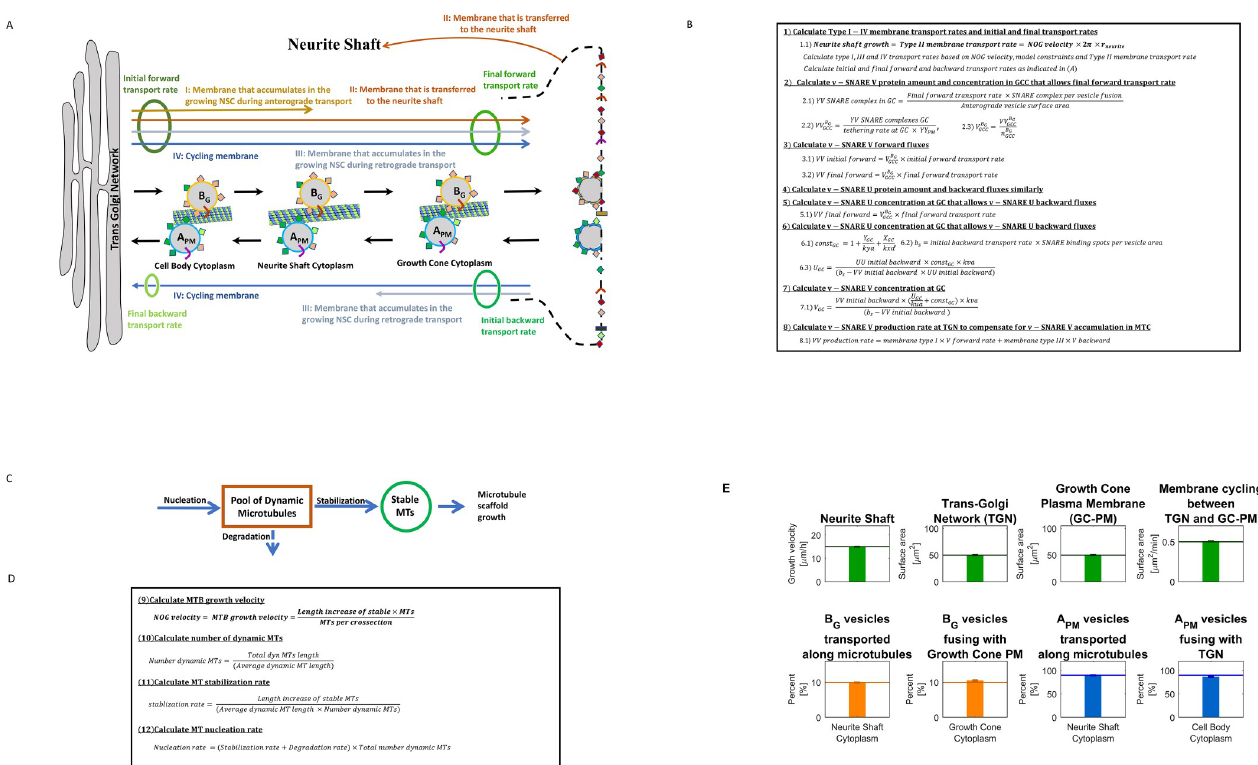
Fig 5. Generation of an analytical solution for the prediction of kinetic parameters at steady state. (A) The development of the analytical solution depends on the categorization of membrane fluxes based on their destination compartment. Such classification distinguishes four different membrane types (I-IV) (that should not be confused with the four different vesicle types we show in Fig 2B). Initial and final anterograde and retrograde transport rates (which refer to budding and fusion rates at the TGN and GC) are the sum of the transport rates of the encircled membranes types. (B) Calculation of kinetic parameter for v- SNARE V. VV/YY/UU refer to total count of SNAREs, V/Y/U describe concentration of SNAREs (per membrane area). See supplementary methods for complete derivation of analytical solution. (C) Microtubule bundle (MTB) growth is mediated by the conversion of dynamic MTs into stable MTs. Dynamic MTs nucleate de-novo, followed by their degradation or stabilization. (D) Nucleation, stabilization and degradation rates for dynamic MTs are calculated as shown. (E) To verify our analytical solution we analyzed, whether our predicted parameter sets allow neurite outgrowth with the selected velocity and without violation of model constraints. For each velocity, we selected 6 different parameter sets that differ in the number of v-SNARE V and the tethering rate at the growth cone plasma membrane (S5A Fig). Every 500 min over a simulation period of 5,000 min (~3.5days), we documented the indicated outputs. Averages and standard deviations were calculated for each velocity. As shown for a velocity of 15 μ m/h, our analytical solution predicts steady state dynamics that match the anticipated model constraints (horizontal lines) with high